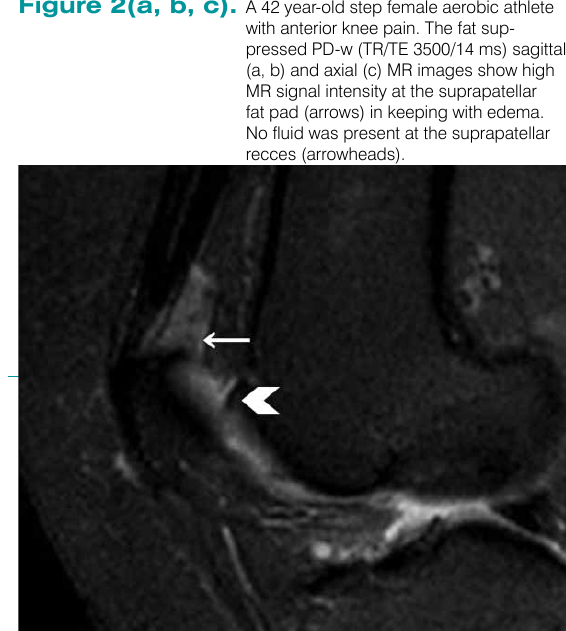
Figure 2(a, b, c). A 42 year-old step female aerobic athlete with anterior knee pain. The fat sup- pressed PD-w (TR/TE 3500/14 ms) sagittal (a, b) and axial (c) MR images show high MR signal intensity at the suprapatellar fat pad (arrows) in keeping with